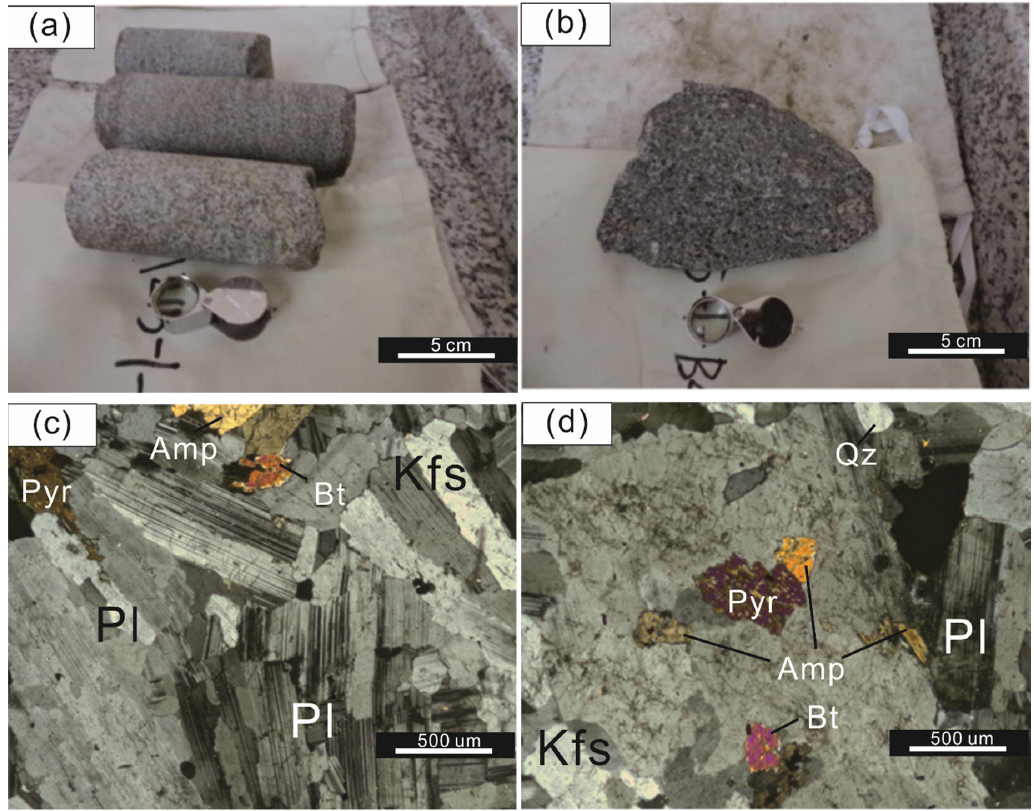
Figure 2. Photographs and photomicrographs of Mingze monzodiorites. ( a ) and ( b ): Two selected hand specimens of monzodiorite. ( c ) and ( d ): Mineral assemblage of monzodiorite. Abbreviations: Qz—quartz, Pl—plagioclase, Kfs—K-feldspar, Pyr—pyroxene, Amp—amphibole, Bt—biotite.